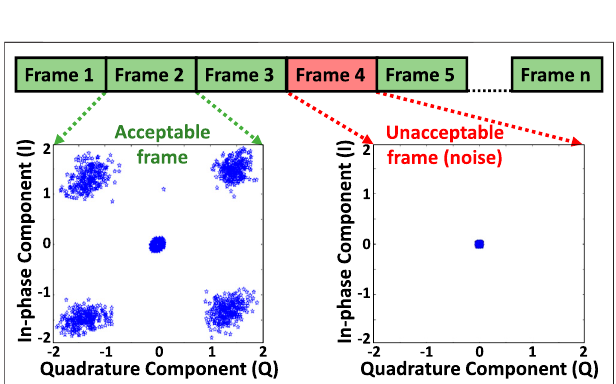
FIGURE 3 | Grouping collected data in a number of frames and fi ltering of data for acceptable frames. This step is required as the Xbee module transmits data on an